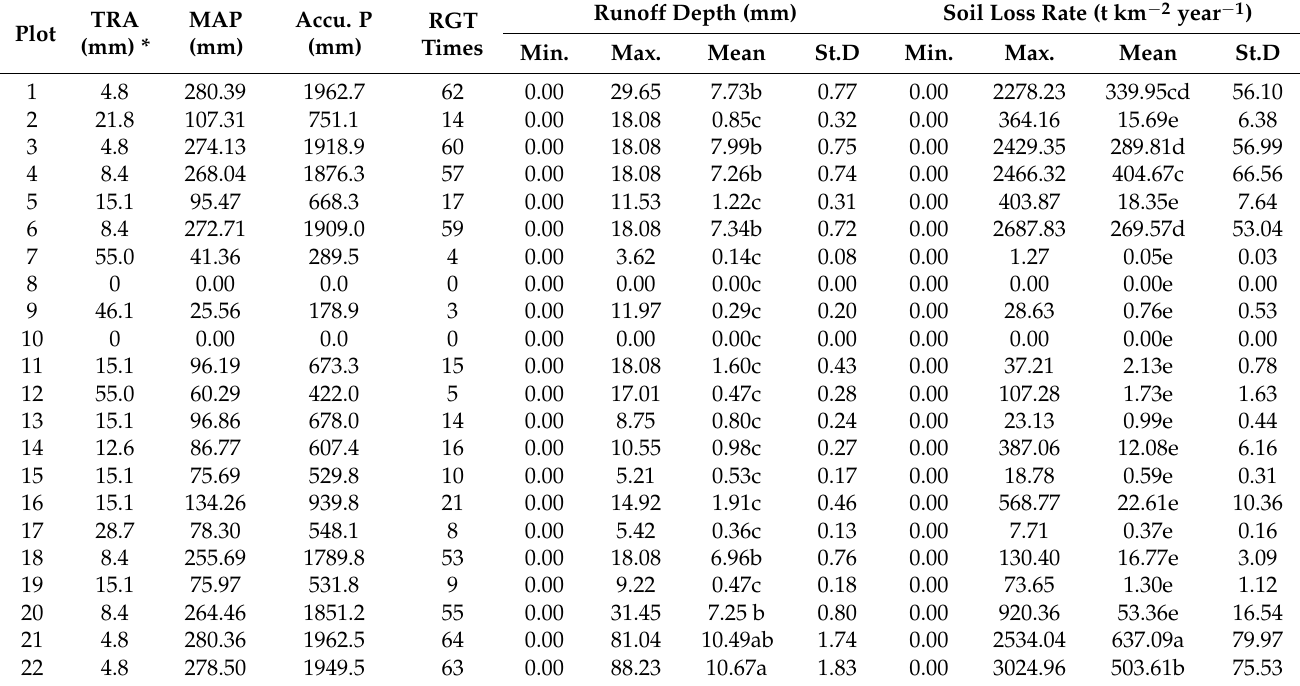
Table 3. Characteristics of threshold rainfall, runoff, and soil loss characteristics for the 22 plots in